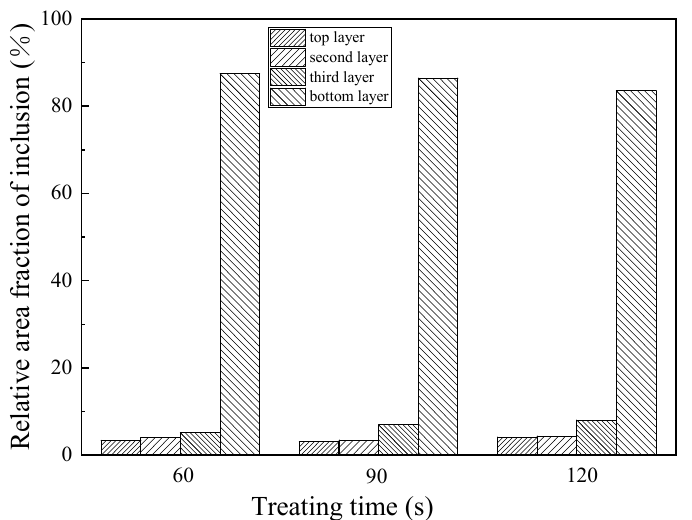
Figure 8. Variation of relative area fraction of inclusion with ultrasonic treating time.